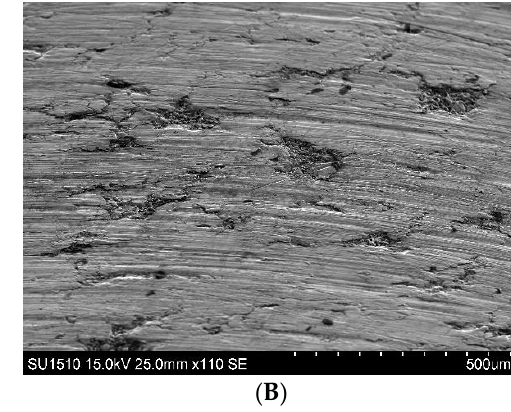
Figure 2. Electron microscopic images of Ti6Al4V test specimens produced by SLM. ( A ) without burnishing as is manufactured. This is the edge of a polished cross section, so unevenness of the surface also can be observed. On the upper part, partly melted and adhered metal power particles are visible. ( B ) Cylindrical surface after SFBD. Morphology of the surface changed substantially; a banded pattern is formed by the diamond tool. Valleys not completely filled in are also discernible. SLM parameters: layer thickness: 0.03 mm, hatch distance: 0.14 mm, laser power: 233.33 W, scan speed: 1200 mm/s, laser spot diameter: 0.01 mm, machine: EOS M290 400